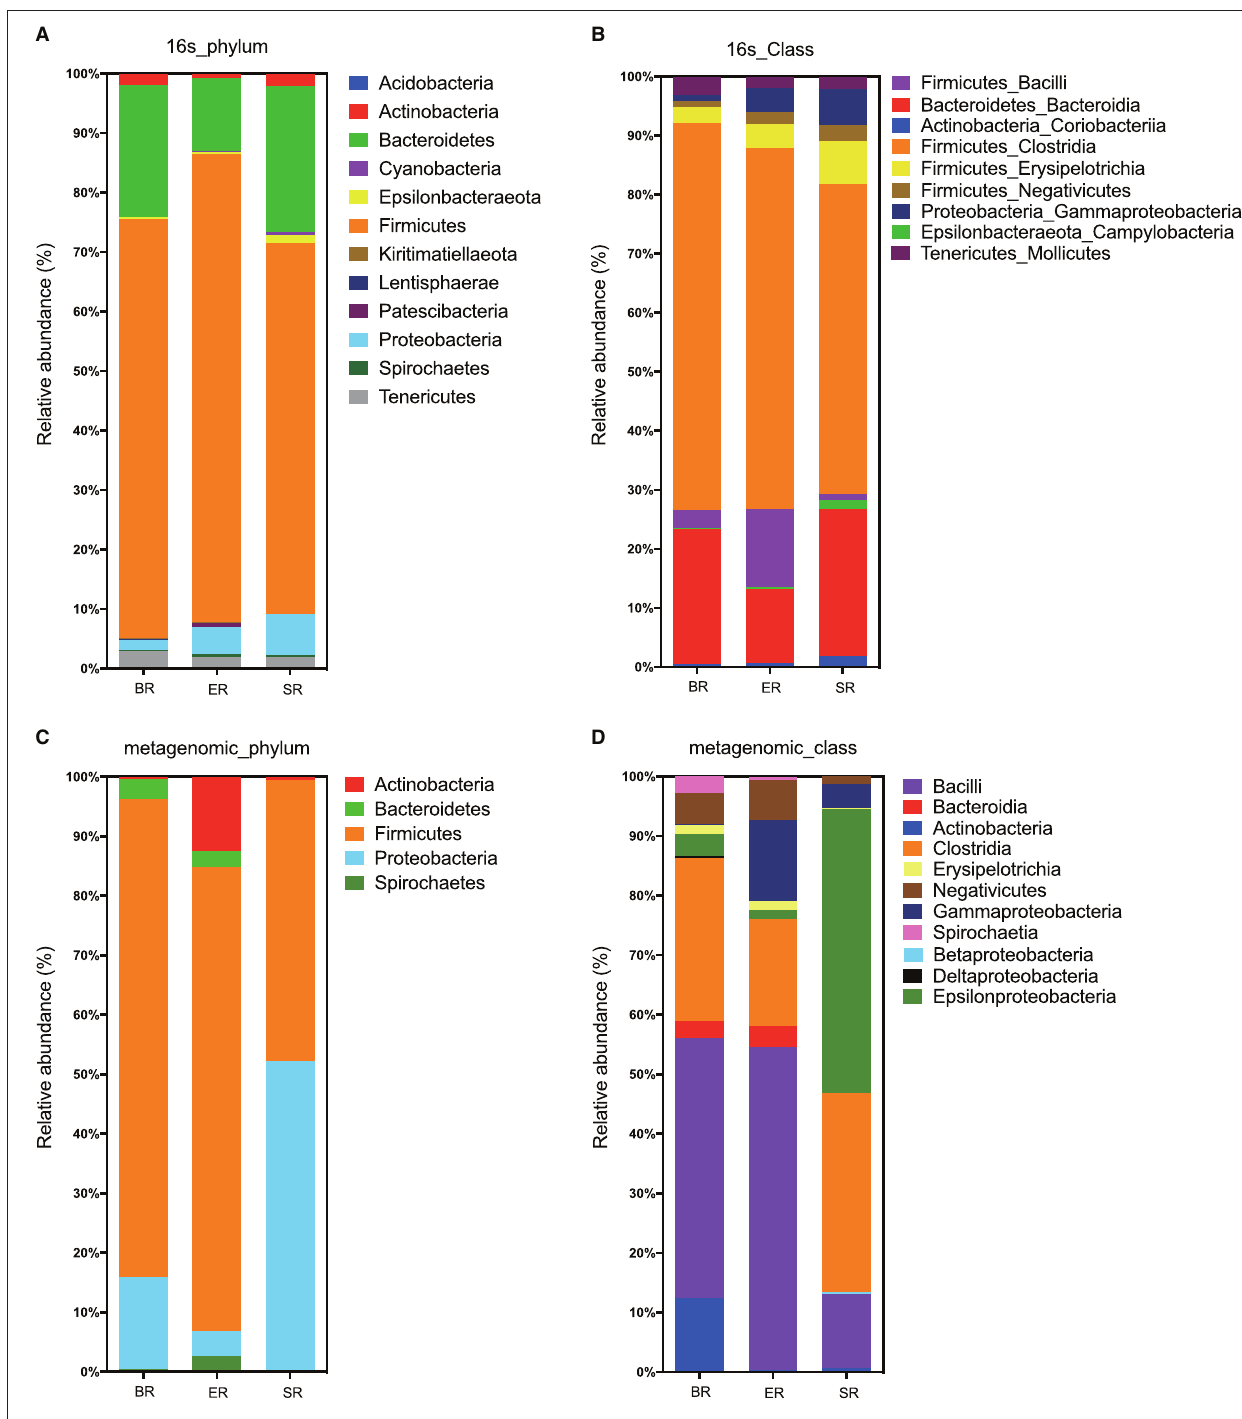
FIGURE 3 | Bacterial read profiling of 16S rRNA sequencing and metagenomic approaches at phylum level (A,C) and class level (B,D) . Stacked columns for the mean of each group of samples enrolled in this study, indicating the relative abundance as a percentage of the total bacterial sequences per group. All data with an abundance of at least 0.1% in at least one subject were included. discovered virus likely represents a new virus species that we tentatively termed “simian adenovirus ER” (GenBank accession number: ( Figure 5 ). Based on its level of sequence divergence, the newly